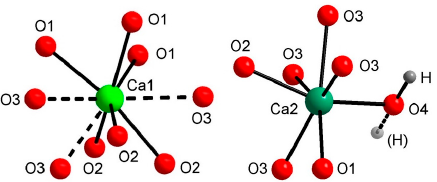
Figure 7. Coordination polyhedra at Ca1 and Ca2 sites in hydroxyapatite. Dashed lines: Ca-O interactions > 2.8 Å. O4 = (OH) site.